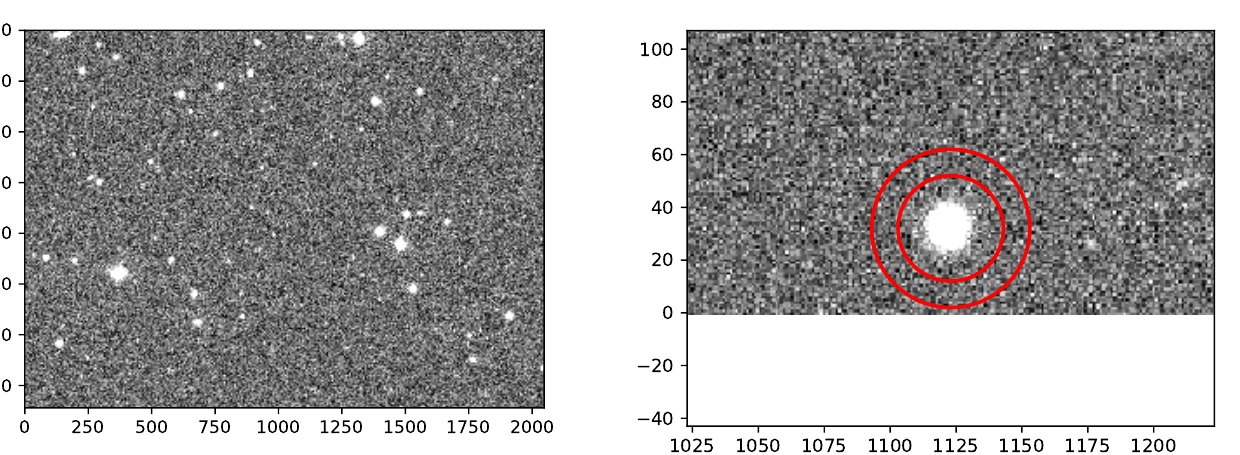
Fig. 100.— Detailed view of the region around the first star, with an inner circle and outer annulus marked